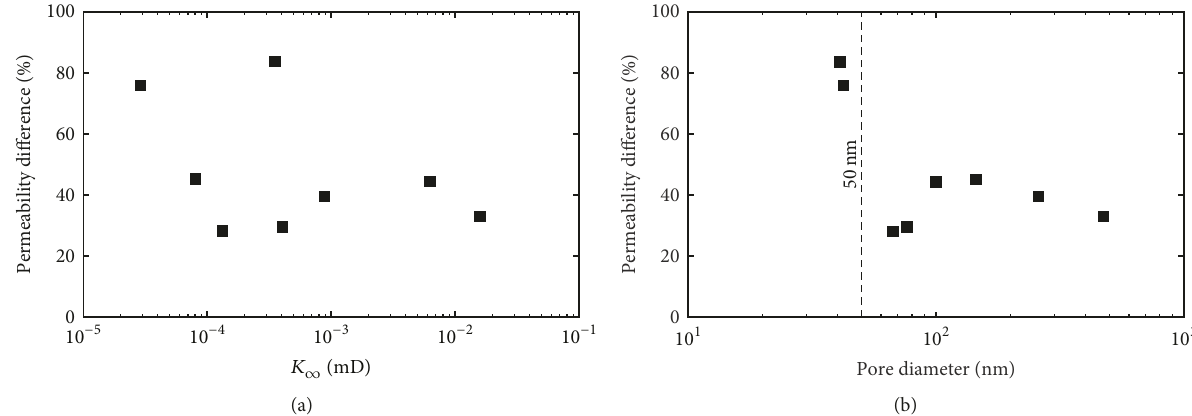
Figure 11: Correlation of difference between predicted ethane gas permeability and measured permeability at 3.45 MPa pore pressure ( 𝑦 -axes) and 𝐾 ∞ (a) and 𝑑